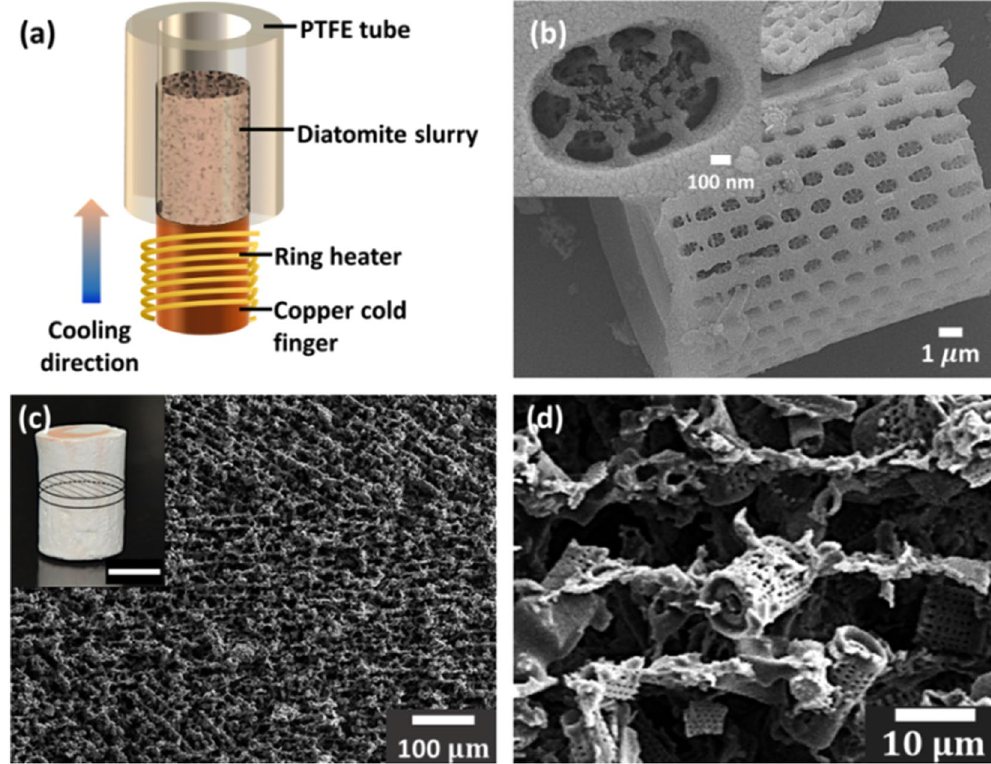
Figure 1. ( a ) Schematic illustration of the freeze-casting system. FE-SEM images show ( b ) the hierarchical structure of a single diatom frustule (Inset: the nano-pores on the silica frustule at high magnification), ( c ) cross-sectional view of the diatomite scaffold synthesized at cooling rate of 5 °C min − 1 , and ( d ) detailed microstructure of diatomites at higher magnification. Inset in ( c ) is a photograph of as-synthesized diatomite scaffold (scale bar: 1